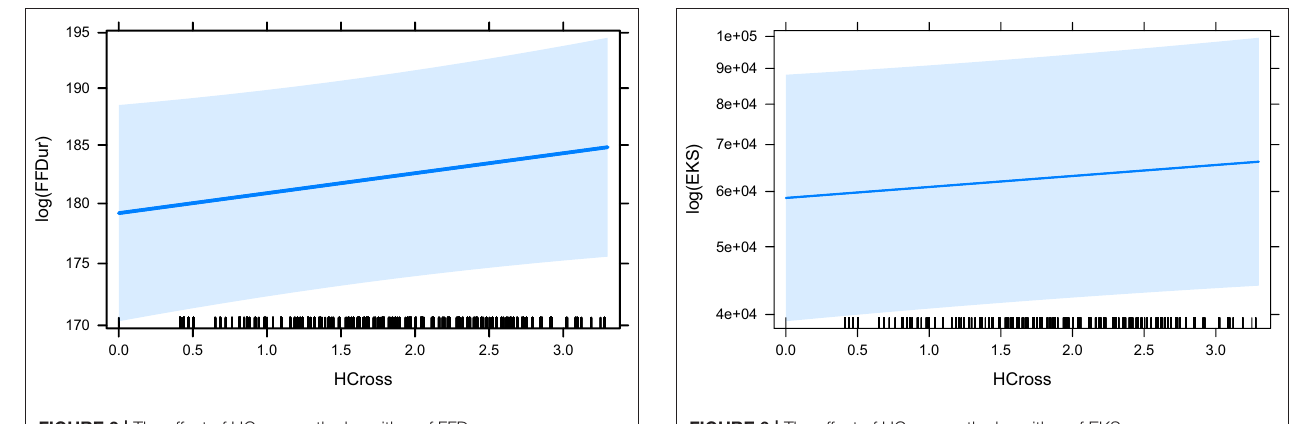
FIGURE 6 | The effect of HCross on the logarithm of EKS.